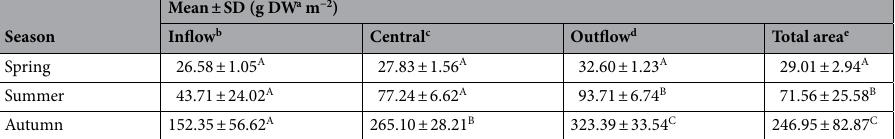
Table 3. Seasonal variability of Nitella mucronata biomass in sub-zones of the main water zone of the Kuźnica clarification pond in 2019. Values with the different superscripts are significantly different among seasons confirmed by non-parametric Kruskal–Wallis test ( p < 0.05). a Dry weight; b H = 2.05, N = 15, df 2, p > 0.05; c H = 7.13, N = 15, df 2, p < 0.05; c H = 22.13, N = 15, df 2, p < 0.01; e H = 79.78, N = 15, df 2, p <